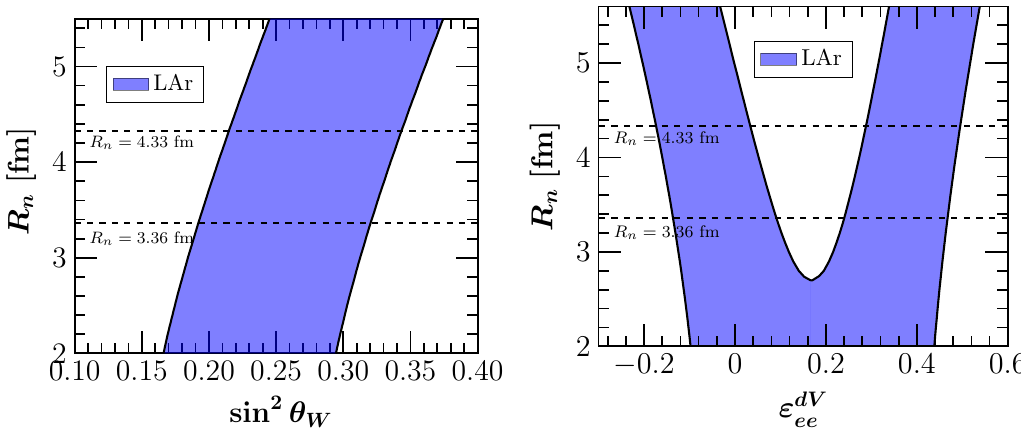
Figure 8 . Allowed region in the parameter space of (sin 2 (cid:18) W ; R n ) (left) and ( (cid:15) dV at 90% C.L. For comparison, the neutron rms radii R n = 3 : 36 fm ((cid:12)xed value) and R n = 4 : 33 fm [upper limit in eq. (3.3)] are indicated with horizontal dashed